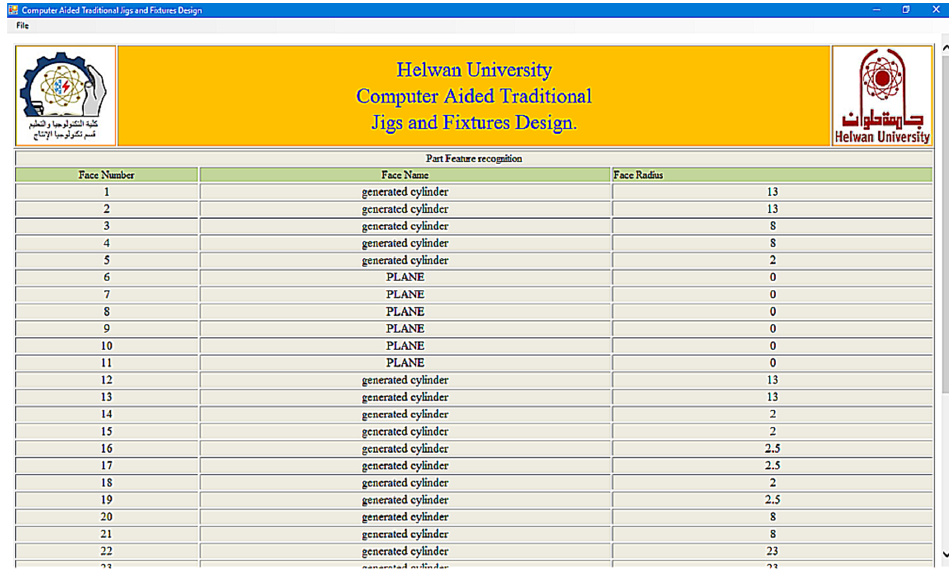
Figure 12. A report of the extracted data.